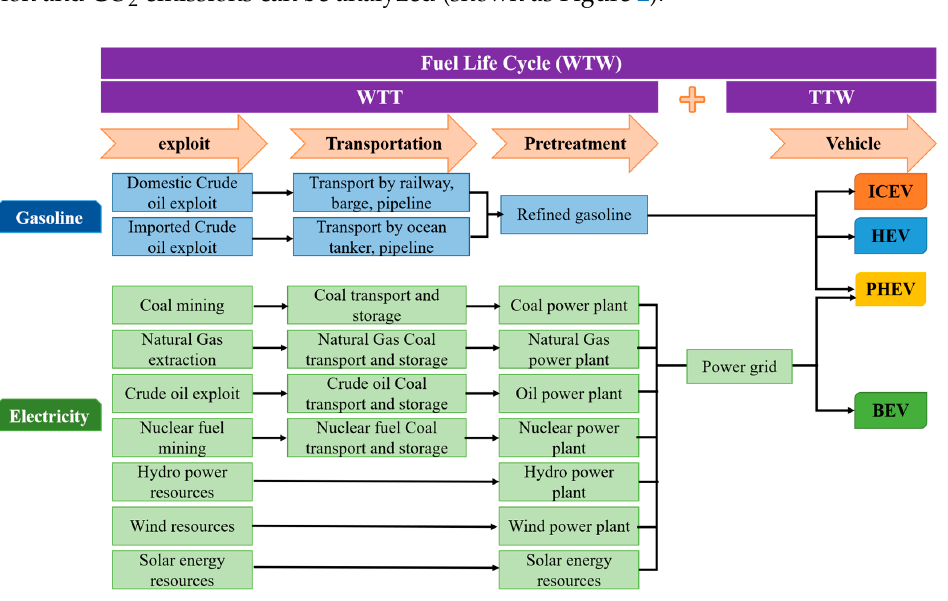
Figure 2. Description of typical fuel paths.